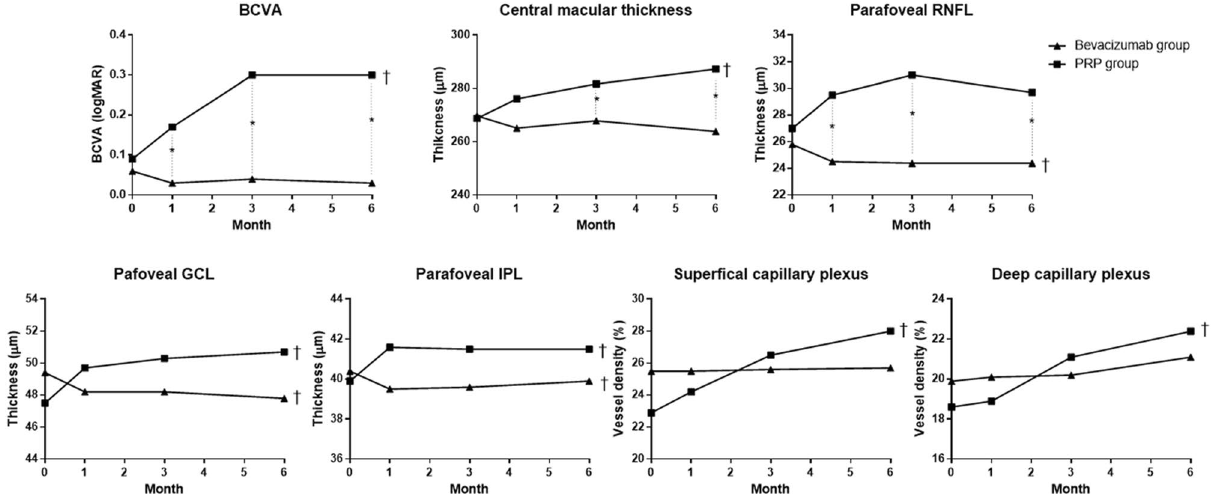
Figure 2. Changes in visual acuity, optical coherence tomography, and optical coherence tomography angiography parameters of each group. *Statistically significant difference between two groups. † Statistically